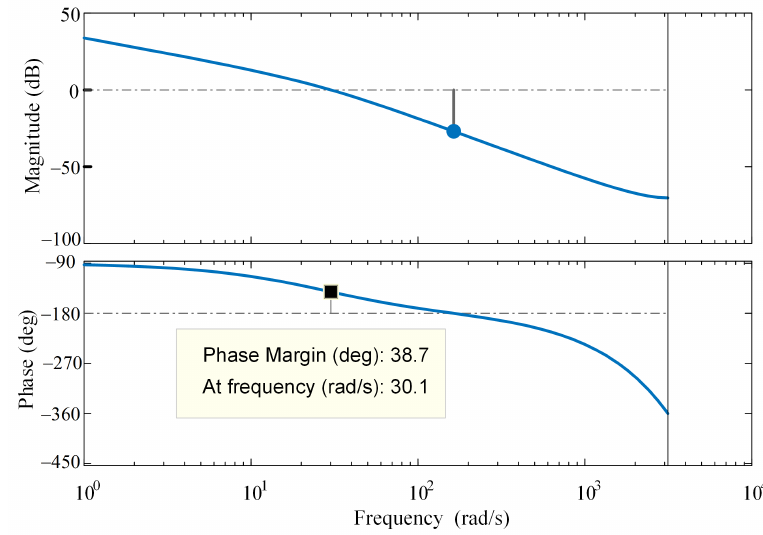
Figure 9. Open-loop Bode diagram of